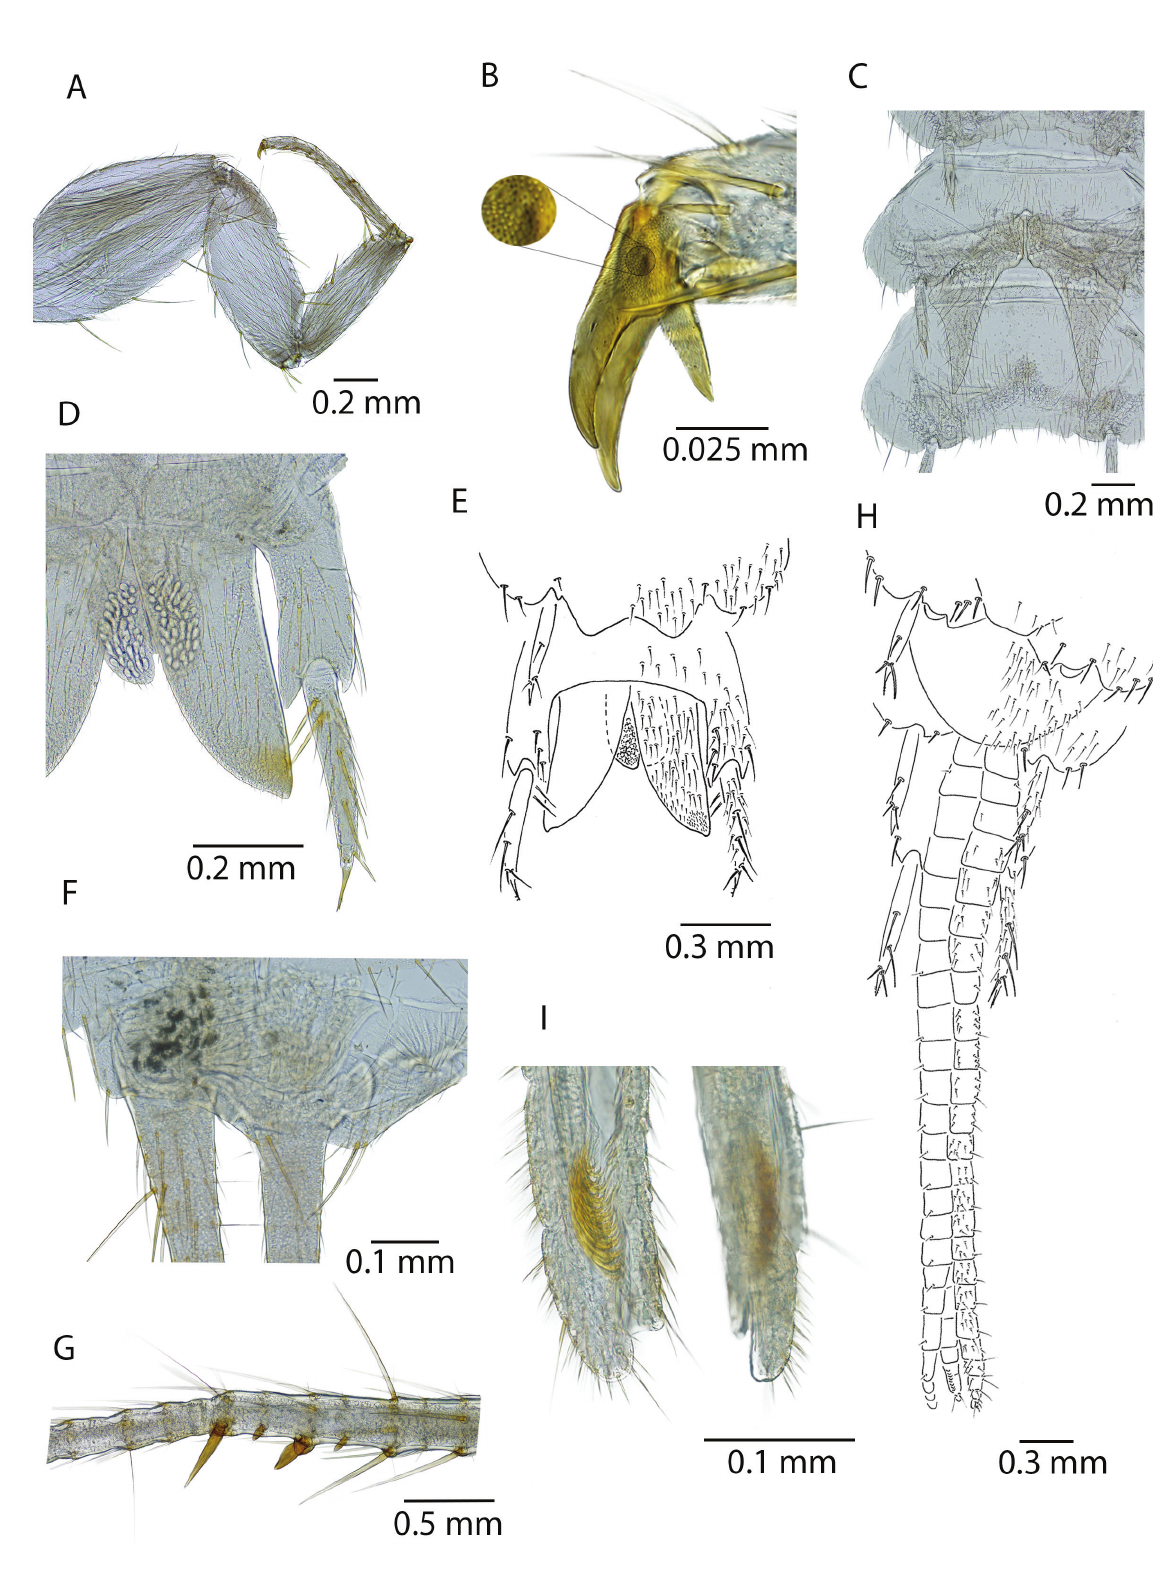
Fig. 2. Anelpistina taninuli sp. nov. Holotype, adult ♂ and paratype, ♀. A . Hind leg. B . Claws with enlarged section showing hairy appearance. C . Urosternum IV. D . Male genital area. E . Urosternum VIII-IX. F . Urotergite X. G . Cercus. H . Ovipositor and subgenital plate. I . Apex